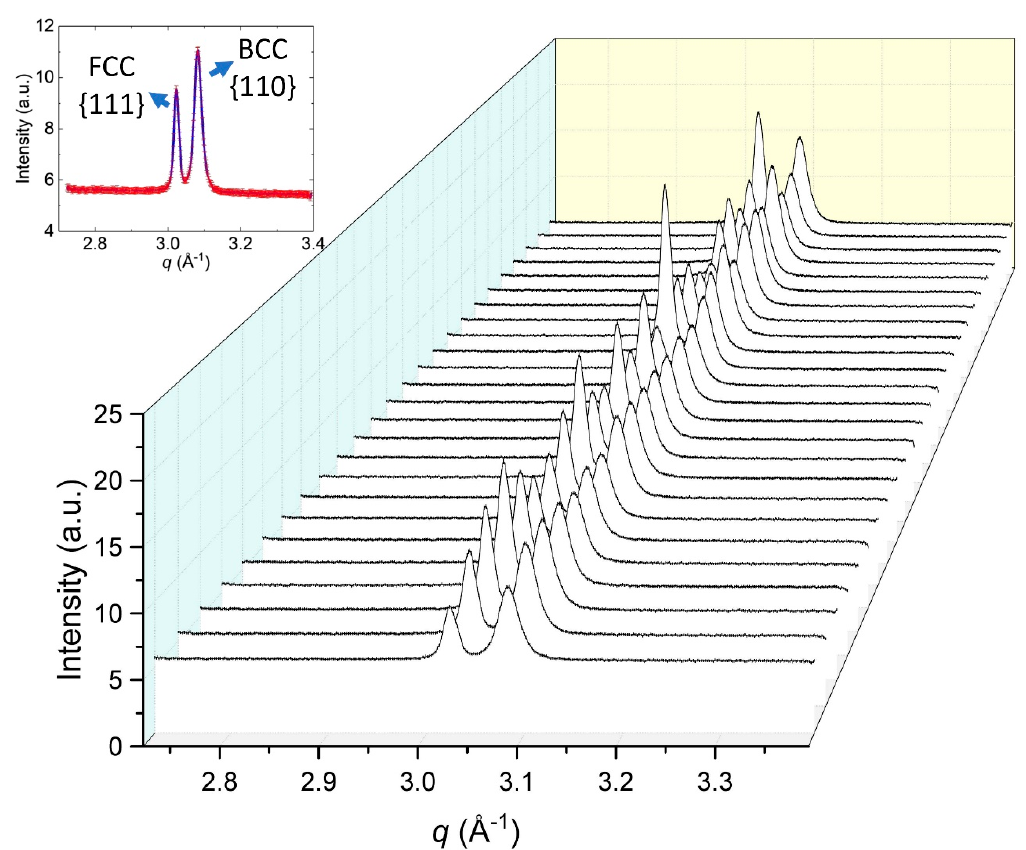
Figure 3. Spatially resolved, in-house XRD data of as-built 17-4 sample with a finely polished surface. For clarity, only the data within a q range of 2.7 Å − 1 and 3.4 Å − 1 are shown. The inset shows the indexing of these two peaks as FCC {111} and BCC {110}, respectively.